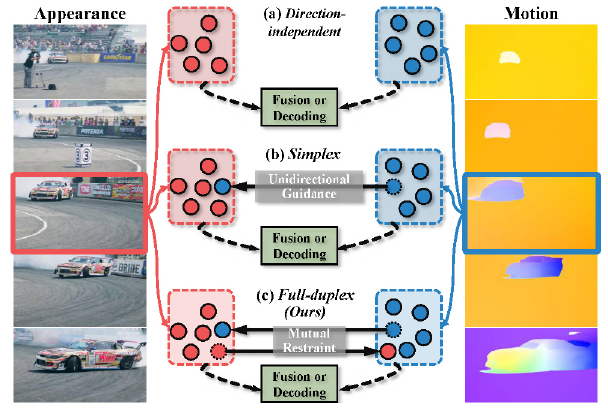
Fig. 1 Three strategies for embedding appearance and motion patterns before the fusion and decoding stage. (a) Direction-independent strategy [21] without information transmission. (b) Simplex strategy [25] with only unidirectional information transmission, with motion guiding appearance or vice versa. (c) Our full-duplex strategy with simultaneous bidirectional information transmission. This paper mainly focuses on discussing directional modelling (b, c) in the deep learning era.